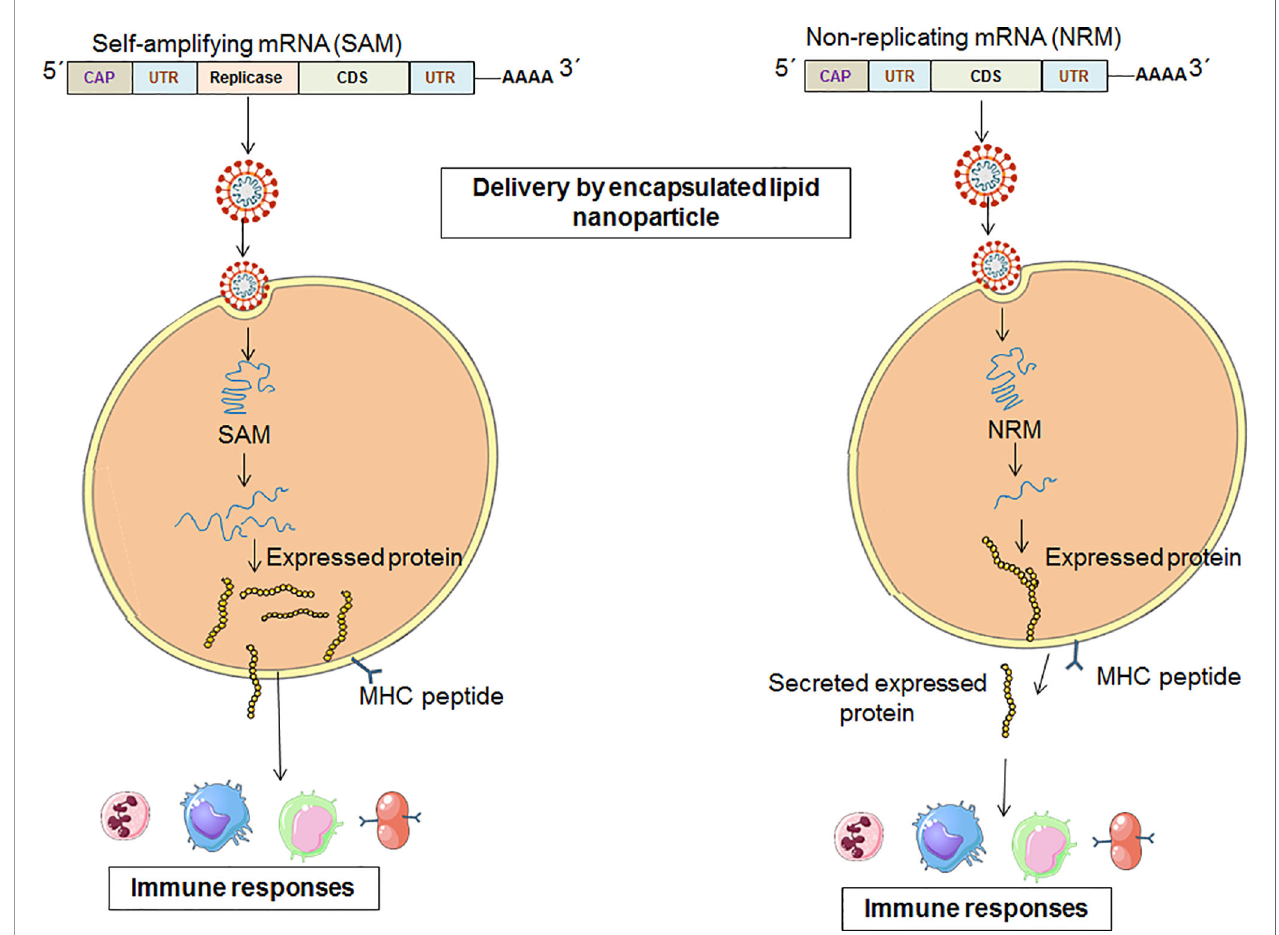
FIGURE 4 | A schematic diagram which explains the pathways from vaccination to immune system activation for the two categories of mRNA vaccine [One for SAM vaccine constructs and other for NRM vaccine